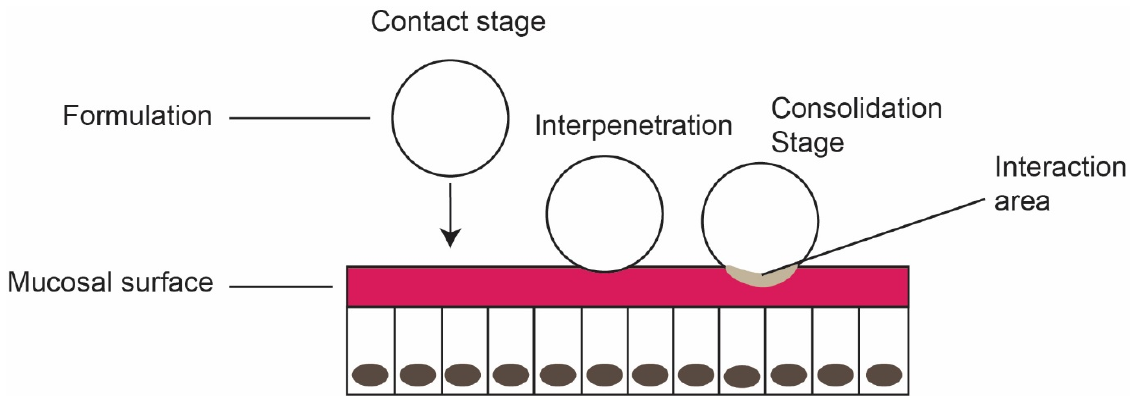
Figure 3. Stages of Mucoadhesion (Reprinted with permission from Smart, J.D, 2005 [23]).